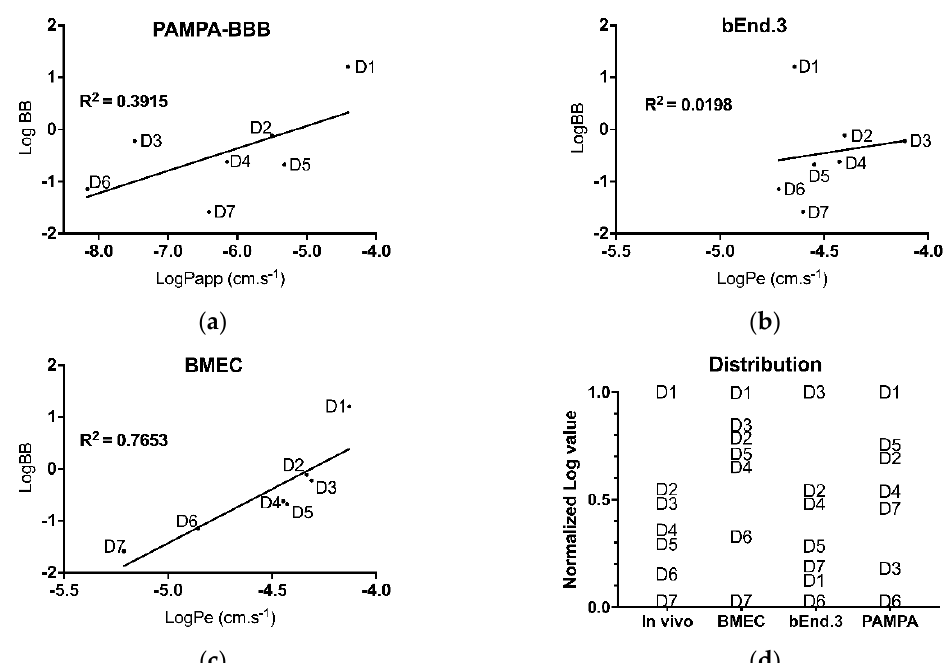
Figure 5. Linear regression plots for in vitro Pe – in vivo log BB correlation (IVIVC) using different models for seven drugs: ( a ) PAMPA-BBB, ( b ) bEnd.3 model and ( c ) BMEC. Pe measurements were realized on day 7. LogBB were quantify 2 h post drugs injection. ( d ) Distribution of drug ranking according to the selected model. D1: chlorpromazine; D2: midazolam, D3 caffeine, D4: theophylline, D5: verapamil, D6: atenolol, D7: tenoxicam. Each point indicates the average Log BB or Log Pe for a given drug ( n ≥ 4 ).